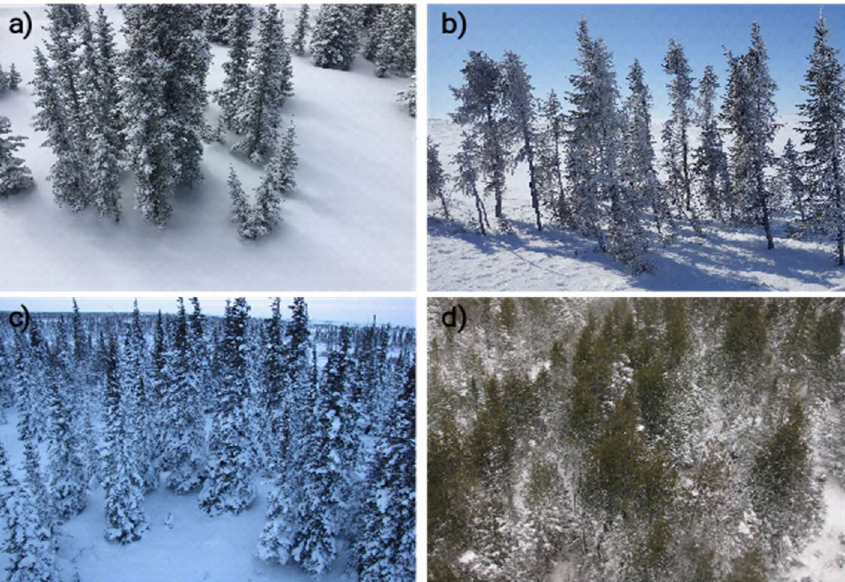
Figure 3. Forested sites at ( a ) Grand Mesa, ( b ) Trail Valley Creek, ( c ) Churchill, and ( d ) Tobermory.